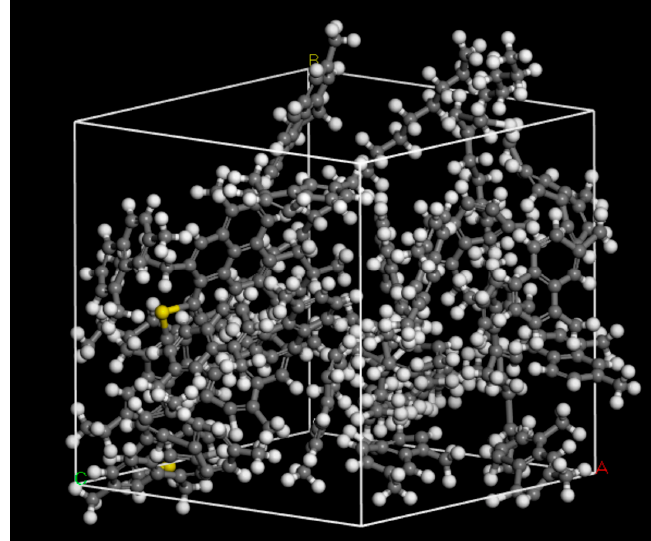
Figure 9. Constructed bitumen molecules ensemble in amorphous cell.